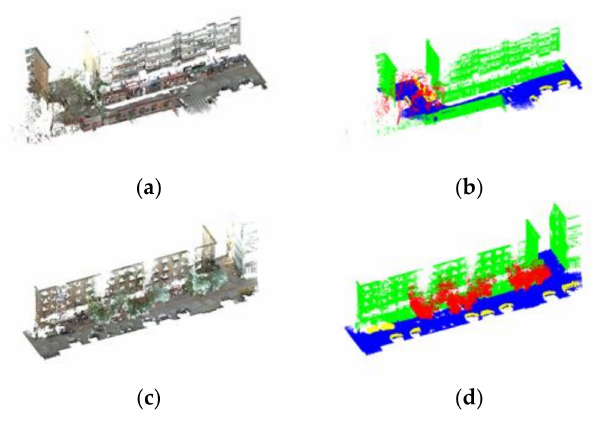
Figure 6. Scene 3 point cloud data. ( a ) Original point cloud of the training set; ( b ) ground truth of the training set; ( c ) original point cloud of the test set; and ( d ) ground truth of the test set. Red, green, yellow, and blue points represent trees, cars, buildings, and floors,